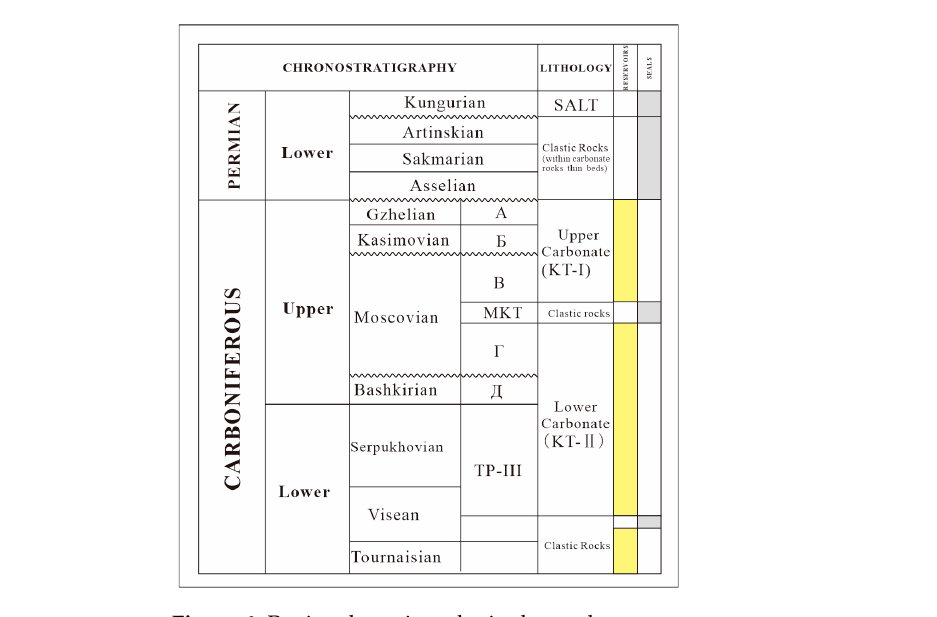
Figure 5. Hydrocarbon accumulation model of Central Block.